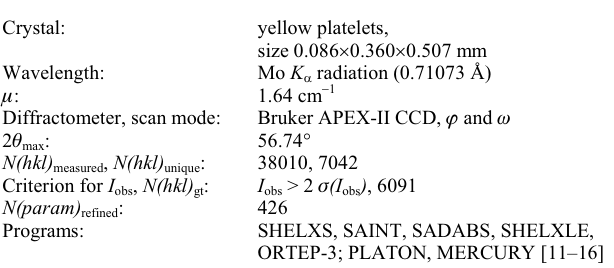
Table 1. Data collection and